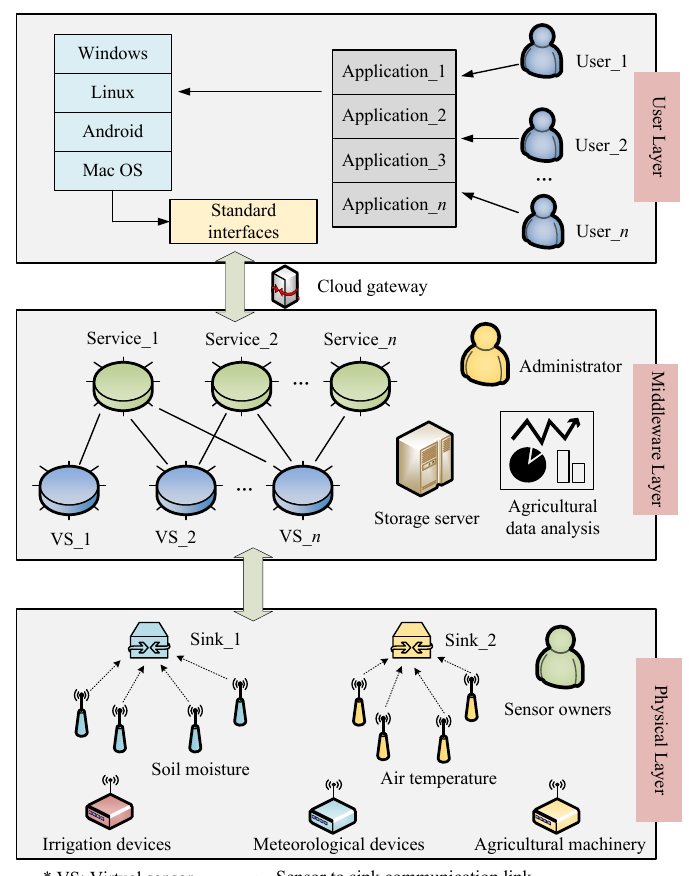
Figure 1. Layered structure of agriculture